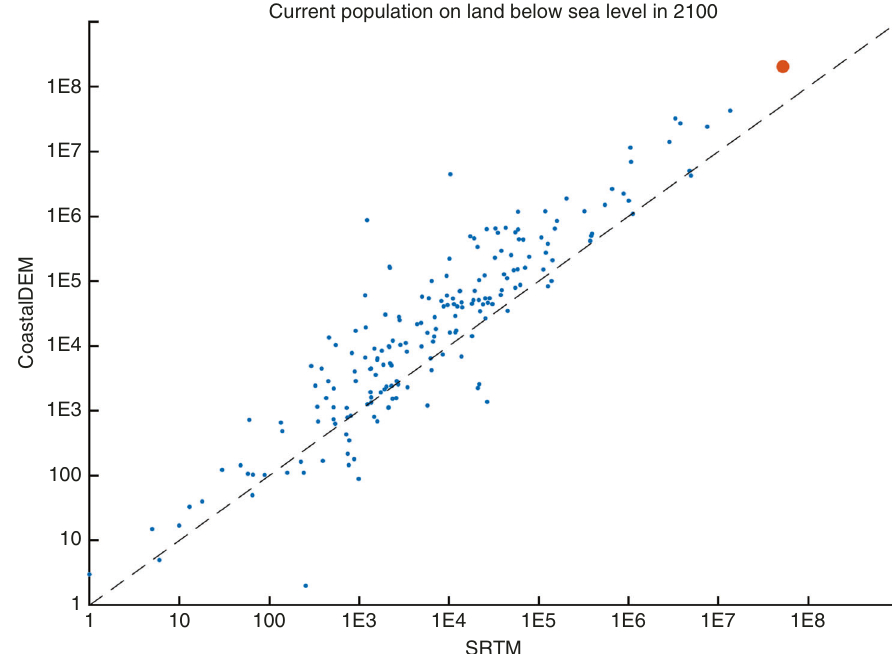
Fig. 3 CoastalDEM versus SRTM by country. Each point represents a country, and its position corresponds to estimated total current population on land below the projected mean higher-high water level in 2100 (K14/RCP 4.5) using CoastalDEM ( y -axis) versus SRTM ( x -axis). The total global value is designated with the red point. Very large differences typically indicate large low-lying areas hydrologically connected to the ocean under CoastalDEM, but not SRTM. Source data are in Supplementary Data